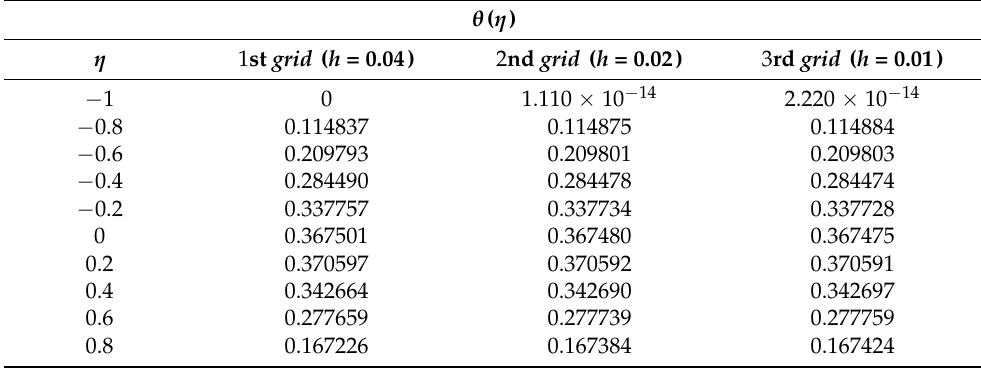
Table 3. Heat transfer rate for different grids levels.